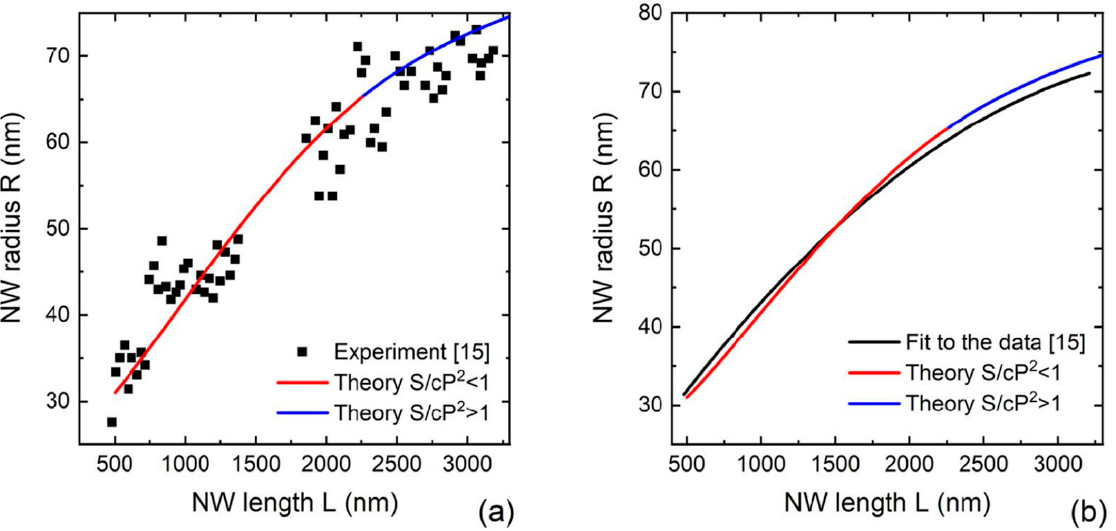
Figure 4. ( a ) Comparison of the model solution with the data of Ref. [15] on the morphological evolution of Ga-catalyzed GaP NWs grown in regular array on SiO 2 /Si(111) surface. ( b ) Same as ( a ) for the average NW radius, fitted by quadratic time dependence in Ref. [15]. The red and blue lines correspond to the solutions before and after the full shadowing of the silica mask, respectively.